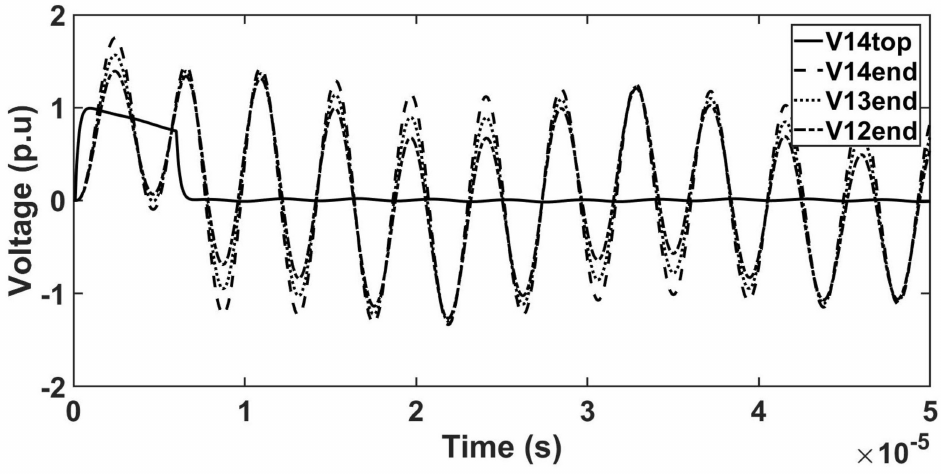
Figure 22. Surge voltage waveforms for grounded shield placement between layer 14 and layer